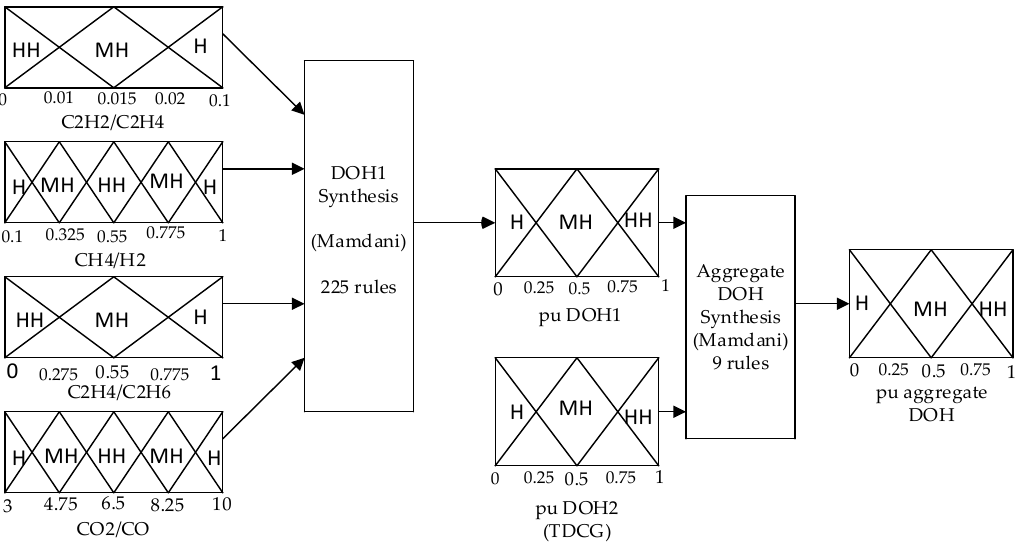
Figure 2. An illustration diagram showing how degree of healthiness (DOH) is evaluated by fuzzy logic .